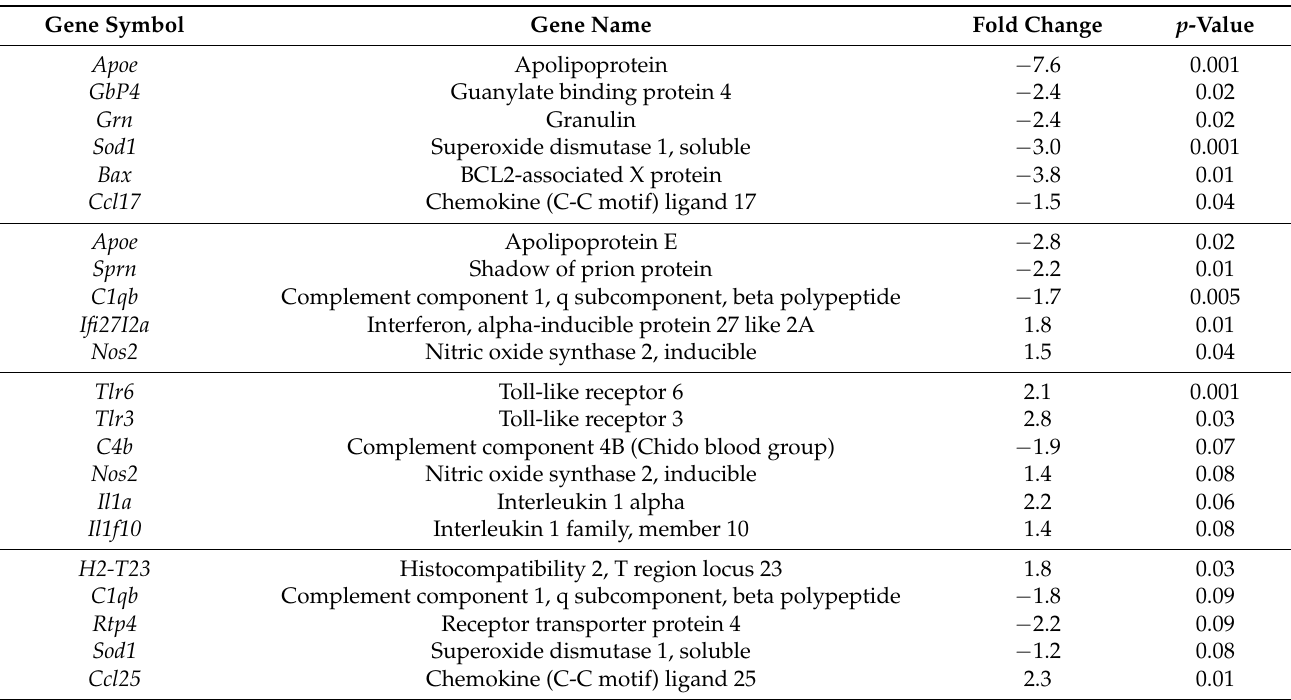
Table 1. List of differentially expressed genes in the brains of mice treated with LPS, moPrP res , moPrP res /LPS, RML/LPS, and RML at 11 weeks of post-inoculation.